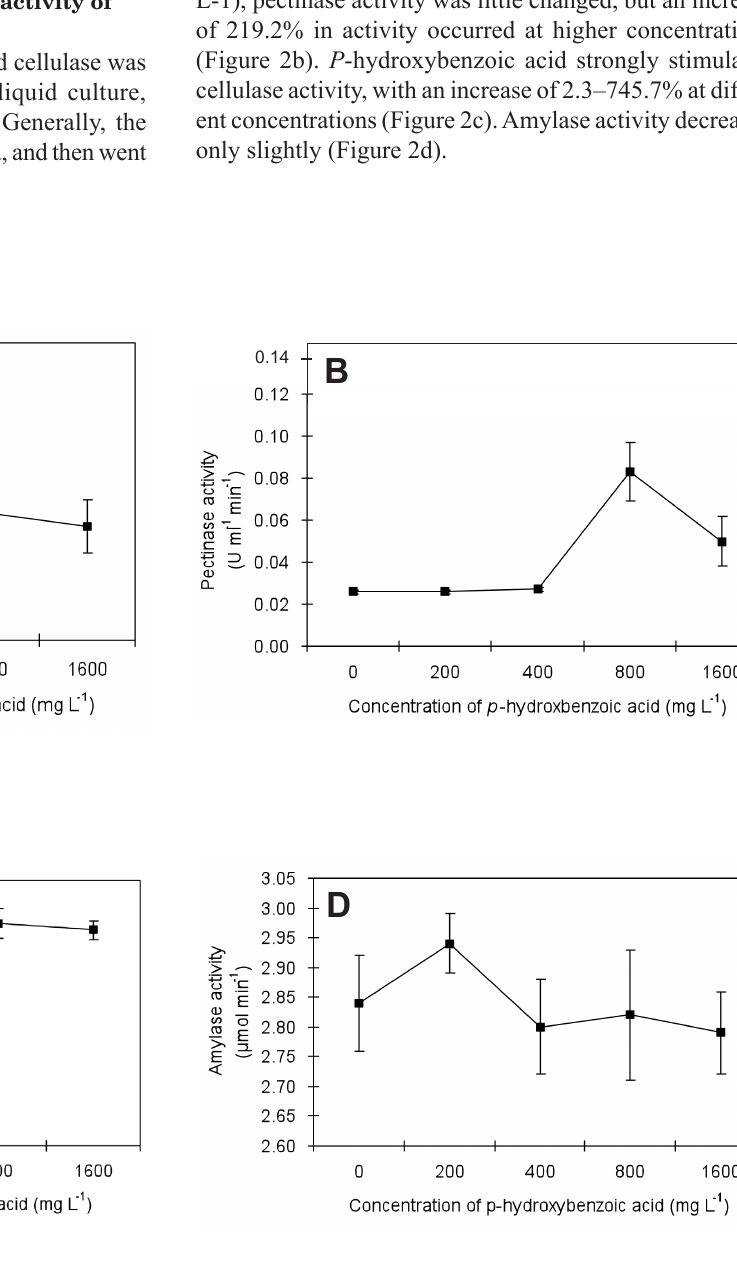
Figure 2. Effect of p- hydroxybenzoic acid on phytopathogenic enzyme activity of Fusarium oxysporum f. sp. niveum in a potato dextrose liquid culture at 28°C, 180 rpm: A, proteinase; B, pectinase; C, cellulase; D, amylase. 0, 200, 400, 800 and 1600 mg L -1 of p- hydroxybenzoic acid were used. Bars indicate standard deviation of three replicates for each